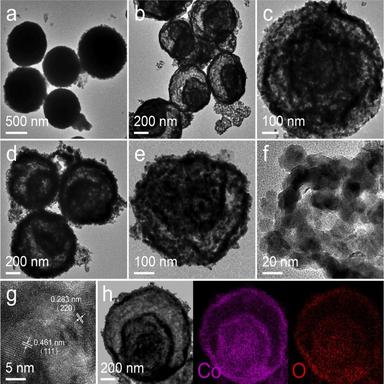
TEM images of (a) Co-MOF, (b, c) MS-Co3O4 and (d-f) MS-VO-Co3O4. (g) HRTEM image and (h) EDX elemental mappings of MS-VO-Co3O4.